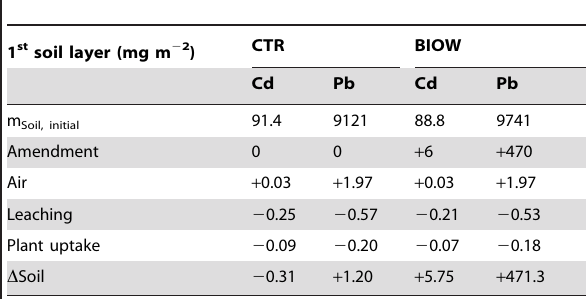
Table 1. Modeled fluxes for top soil, CTR and